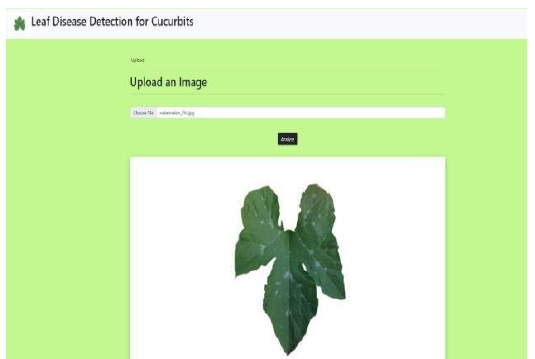
Fig8. Selecting an image for analysis (Diseased)